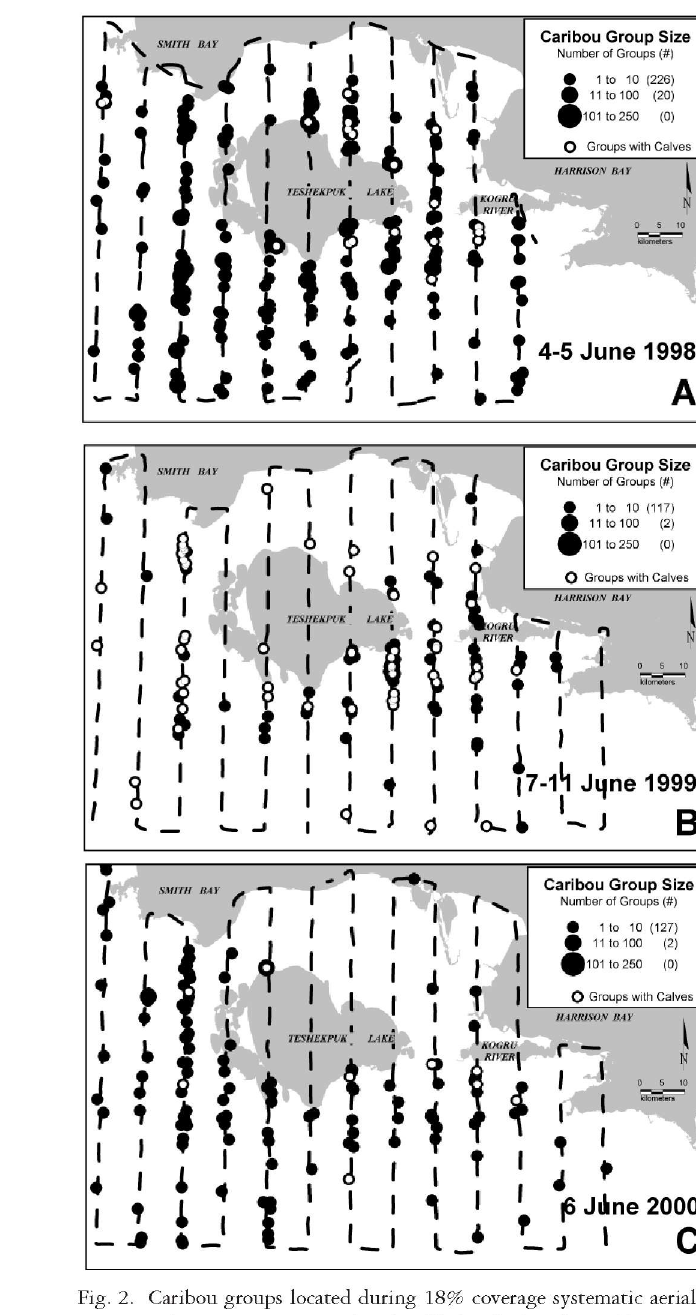
Fig. 2. Caribou groups located during 18% coverage systematic aerial strip-transect surveys in the National Petroleum Reserve— Alaska, June